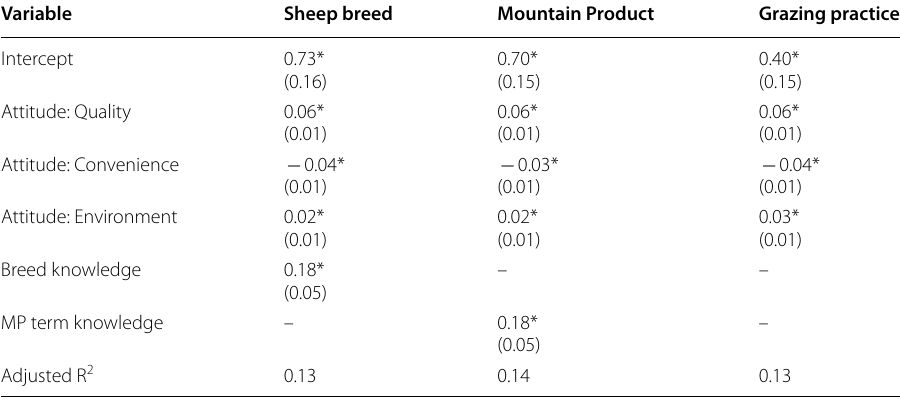
* Statistically significant at the 5%